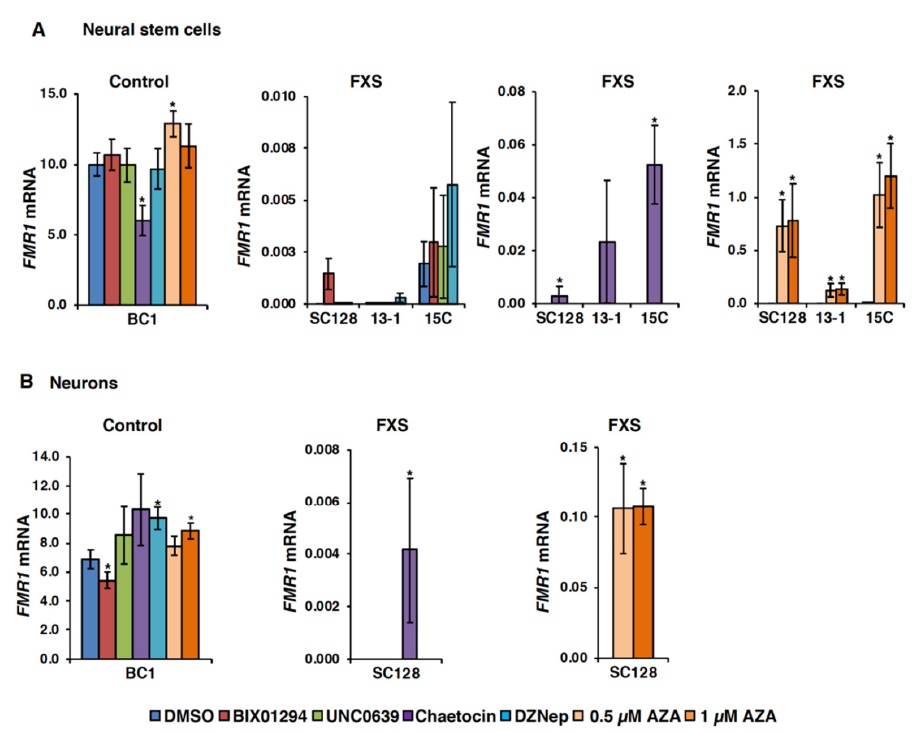
Figure 2. Effect of AZA and HMT inhibitors on the FMR1 mRNA levels in neural stem cells (A) and neurons (B) . Cells were treated with DMSO or HMT inhibitors, 4 µM BIX01294, 100 nM chaetocin, 0.5 µM UNC0638 or 5 µM DZNep for 48 h and with 0.5 µM or 1 µM AZA for 72 h. FMR1 mRNA levels were analyzed by RT-qPCR and are shown as a percentage of GAPDH mRNA . The error bars indicate standard deviation from at least four independent treatments. Statistically significant differences are indicated by an asterisk ( p < 0.05).